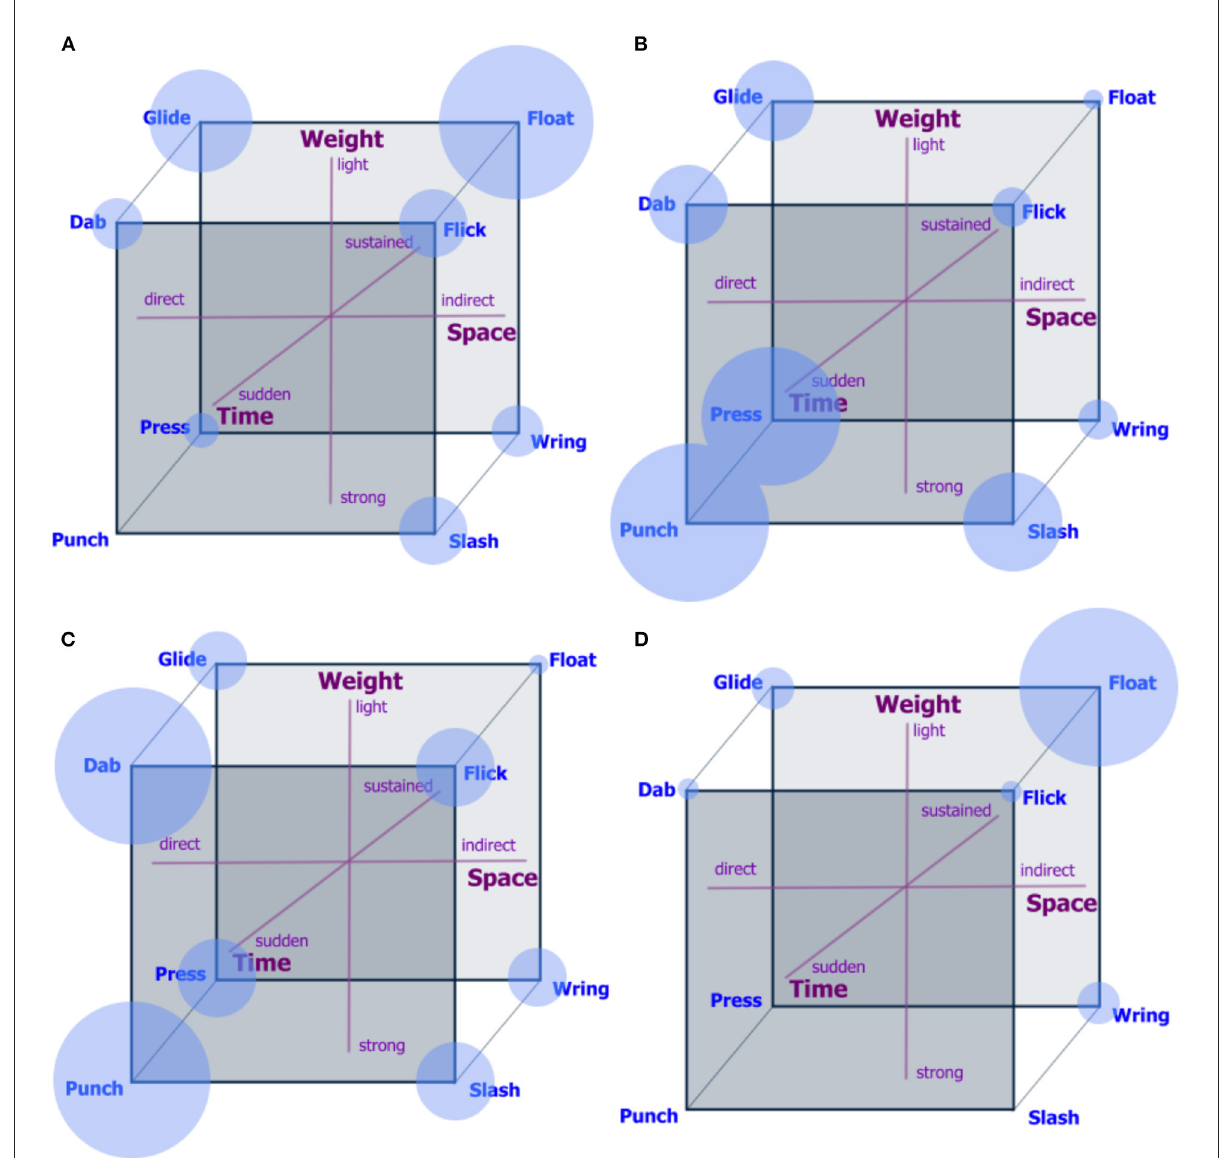
FIGURE13 Visualizations of participants’ Effort annotations on Laban dynamosphere. Panel (A) shows a visualization of annotations of Segment1 (Greek folk), panel (B) shows a visualization the annotations of Segment2 (Flamenco), panel (C) shows a visualization of the annotations of Segment3 (Ballet) and panel (D) shows a visualization of the annotations of Segment4